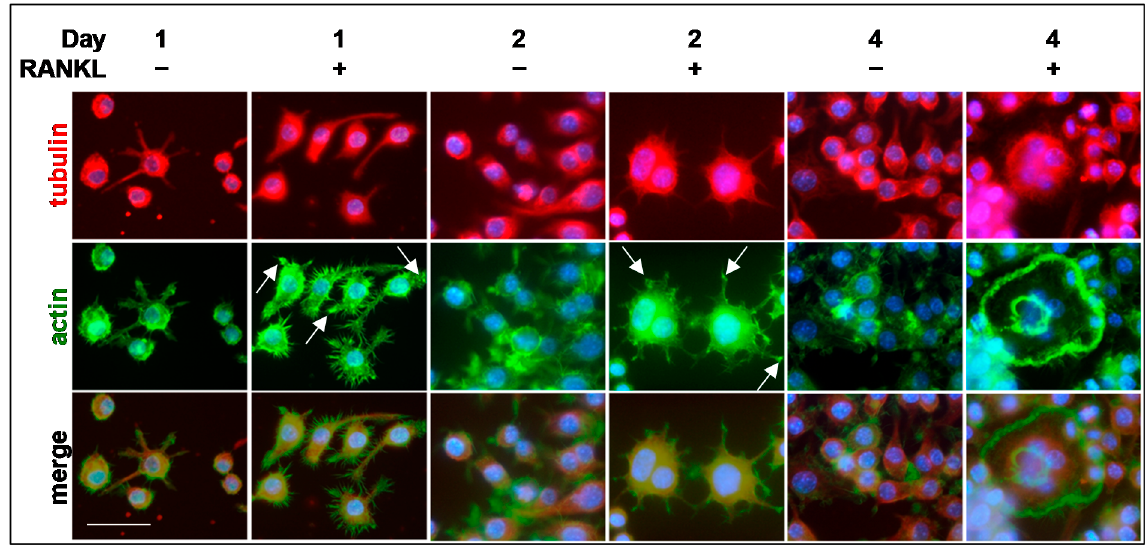
Figure 3. Timing of cytoskeleton organization during OC differentiation. Cells were cultured in absence (RANKL − ) or in the presence of RANKL (RANKL + ) for 4 days. Cells were co-stained with anti-tubulin antibody (red), Alexa Fluor-488 phalloidin (green), and DAPI (blue). White arrows, small F-actin clusters. The data shown represent two independent experiments with comparable outcomes. Magnification 40×. Scale bar of 50 µm.